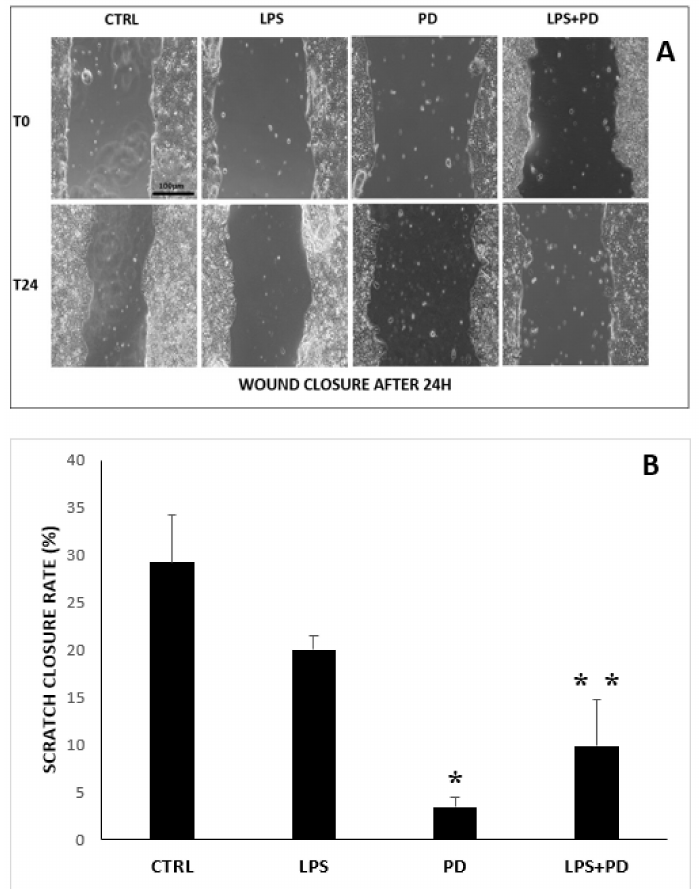
Figure 3. Effects of PD on migration of HT-29 cells. Comparison of migratory activity of control cells and LPS/PD-stimulated HT-29 cells. ( A ) Culture of HT-29 untreated control cells, cells treated with 5 µ g/mL PD, or cells treated with 1 µ g/mL PD+LPS at time 0 (upper plates, 0 h) or after 24 h (lower plates, 24 h). Photographs were taken at x10 magnification using a digital camera under an inverted phase-contrast microscope (Olympus). ( B ) The closure of the scratch was quantified by measuring the difference between the wound width at T0 and T24, using ImageJ software (downloaded from NIH web site: http://rsbweb.nih.gov/ij/); The scratch closure rate (SCR) was calculated using the following formula: SCR = [(At0 − At24)At0] × 100. Results are expressed in terms of the means of three independent experiments ± SD. * p < 0.01, treated with PD (5 µ g/mL) vs. HT-29 controls. ** p < 0.01, HT-29 cells treated with LPS (1 µ g/mL) and PD (5 µ g/mL) vs. HT-29 cells treated with